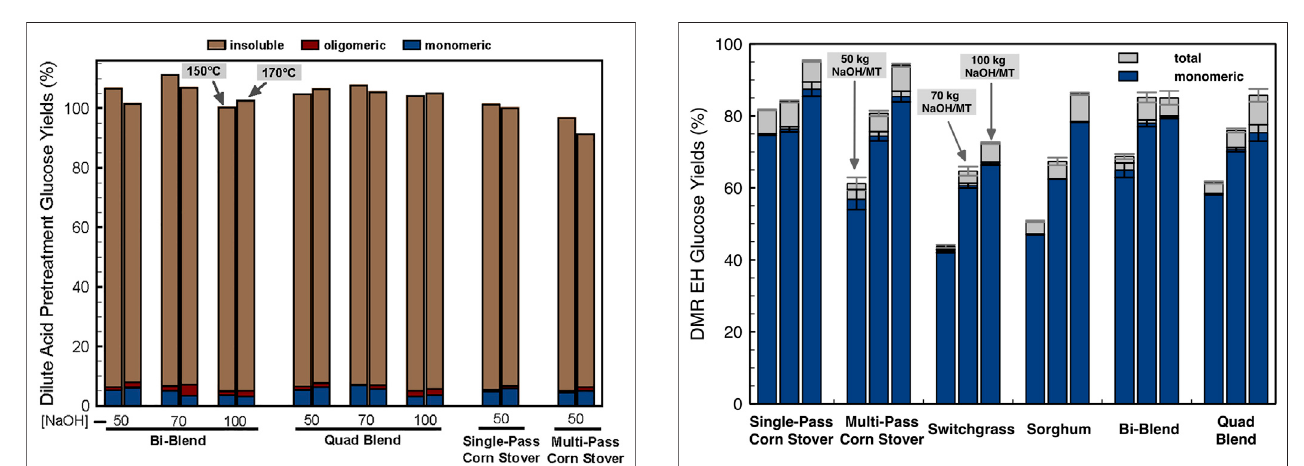
FIGURE6| DDApretreatmentglucoseyields.Theleftbarineachcluster is data from the 150 ° C, 20 min, 1% H 2 SO 4 condition and the right bar represents the 170 ° C, 5 min, 1% H 2 SO 4 pretreatment condition. The numbers on the x -axis note the deacetylation alkali loading in kg NaOH/ ODMT dry biomass with 50, 70, and 100 referring to low, medium, and high deacetylation severity, respectively.